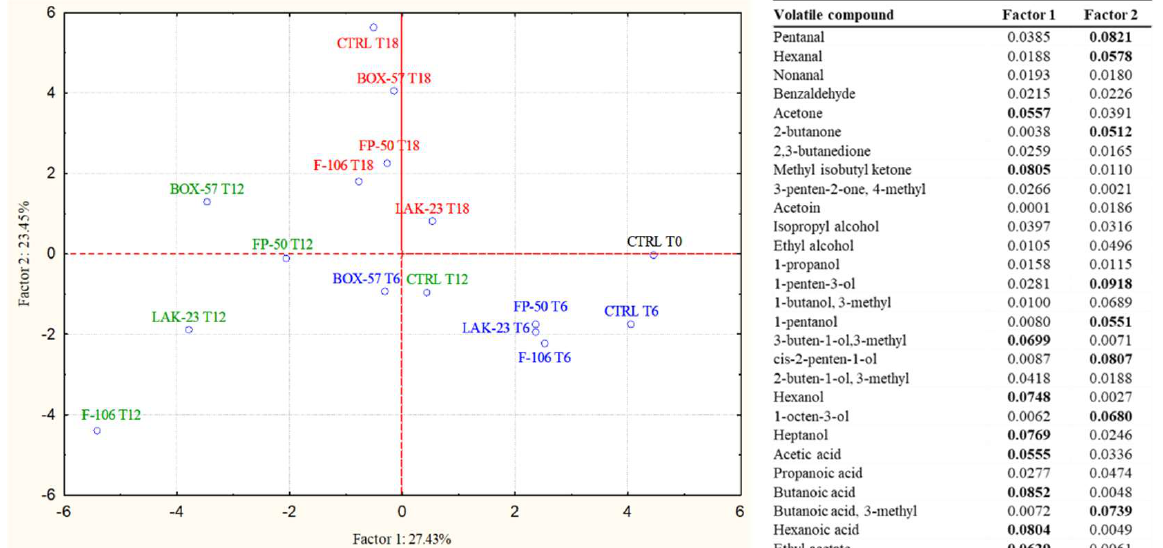
Figure 2. PCA case coordinates for the first two factors, explaining the influence of the different bioprotective cultures on the volatile profiles of fish burgers during storage (0, 6, 12, and 18 days). The factor contribution of the aroma compounds to Factor 1 and Factor 2 are reported as a table.